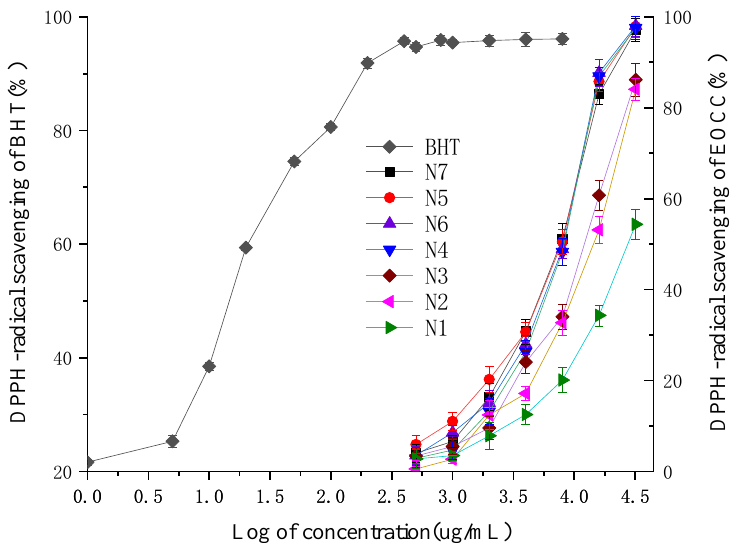
Figure 2. DPPH-radical scavenging activities of the BHT and EOCC. The Spearman test revealed a significant negative correlation ( p ≤ 0.01) between the Table 3. Scavenging activity of the EOCC against DPPH and ABTS free radicals . IC 50 DPPH and oxygenated monoterpenes (OM) in the EOCC (Table 4). The